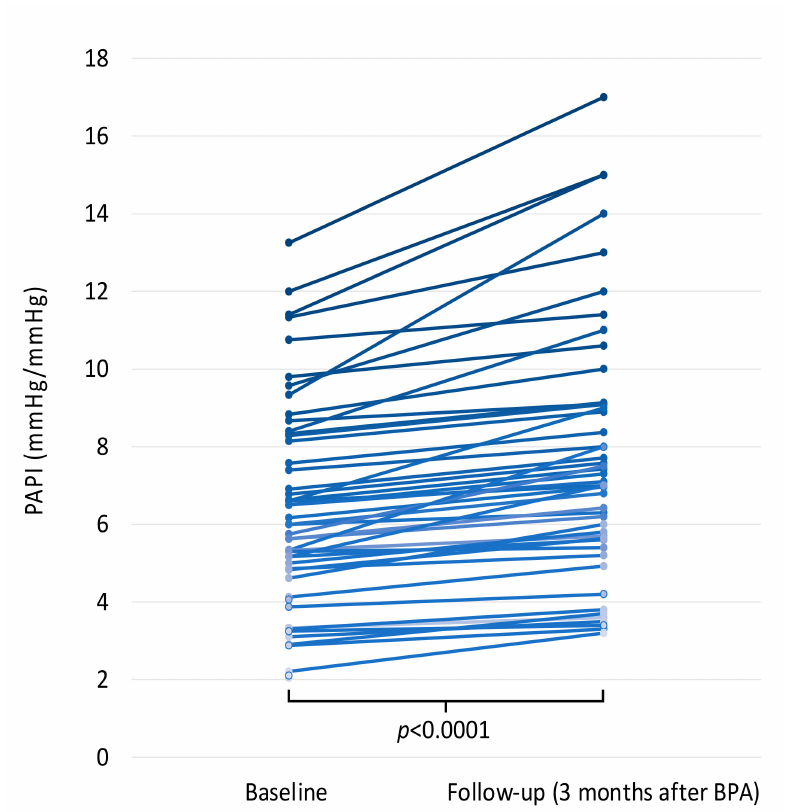
Figure 4. Change in PAPI values from baseline to follow-up 3 months after BPA treatment. Abbrevia- tions: BPA, balloon pulmonary angioplasty; PAPI, pulmonary artery pulsatility